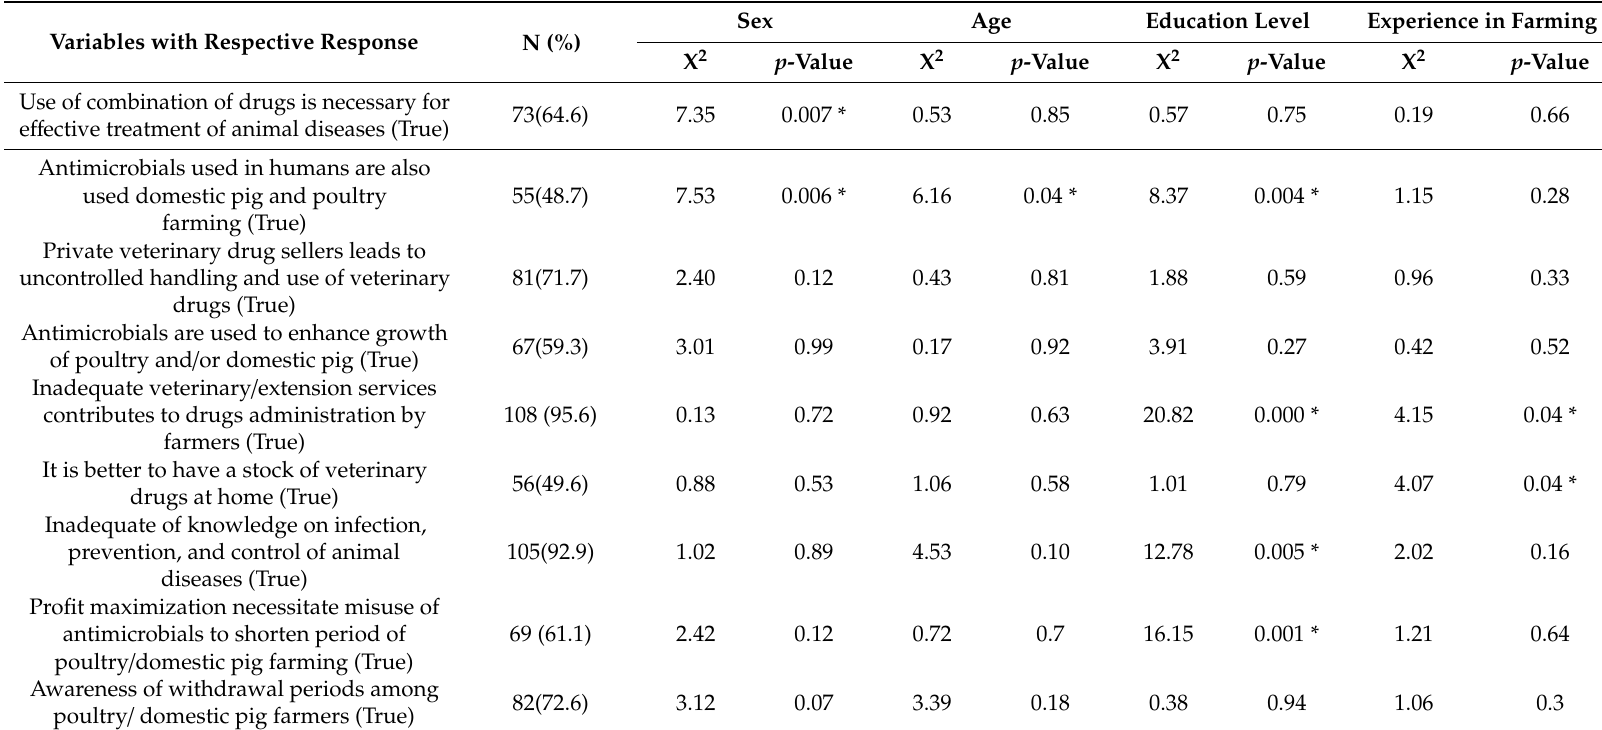
Table 5. Respondent’s perception and attitudes on the drivers of antimicrobial use and resistance in animal farming. Variables with Respective